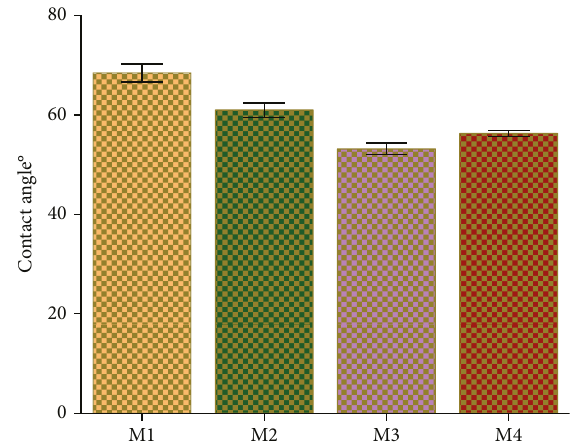
Figure 7: Contact angle values of the prepared membranes. Three measurements for each membrane were taken, and error bar represents standard